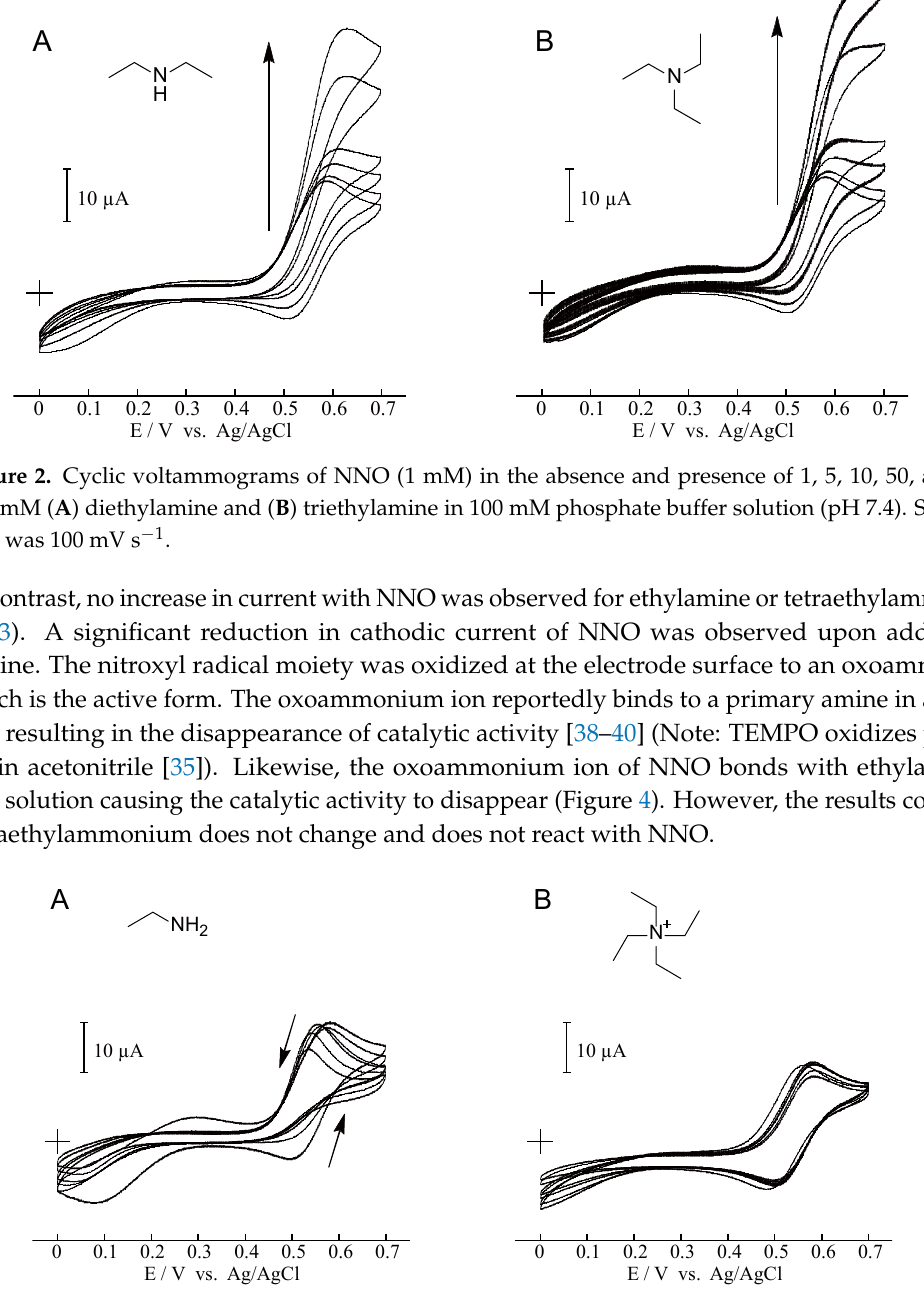
Figure 3. Cyclic voltammograms of NNO (1 mM) in the absence and presence of 1, 5, 10, 50, and 100 mM ( A ) ethylamine and ( B ) tetraethylammonium in 100 mM phosphate buffer solution (pH 7.4). Scan rate was 100 mV s − 1 .